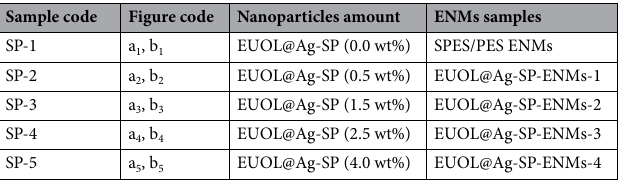
Table 1. EUOL@AgNPs percentage for EUOL@AgNPs-SP-ENMs